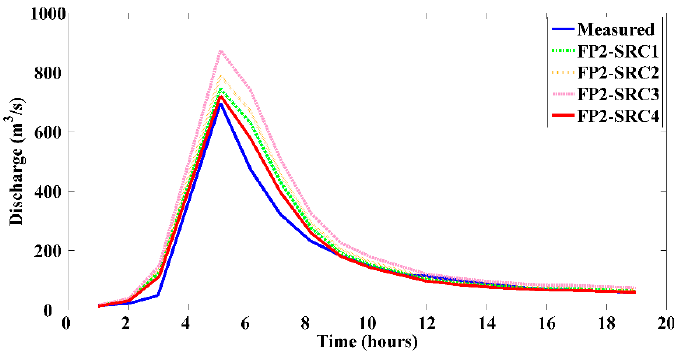
Figure 6. Comparison of the measured and simulated FP2 under the four SRCs.